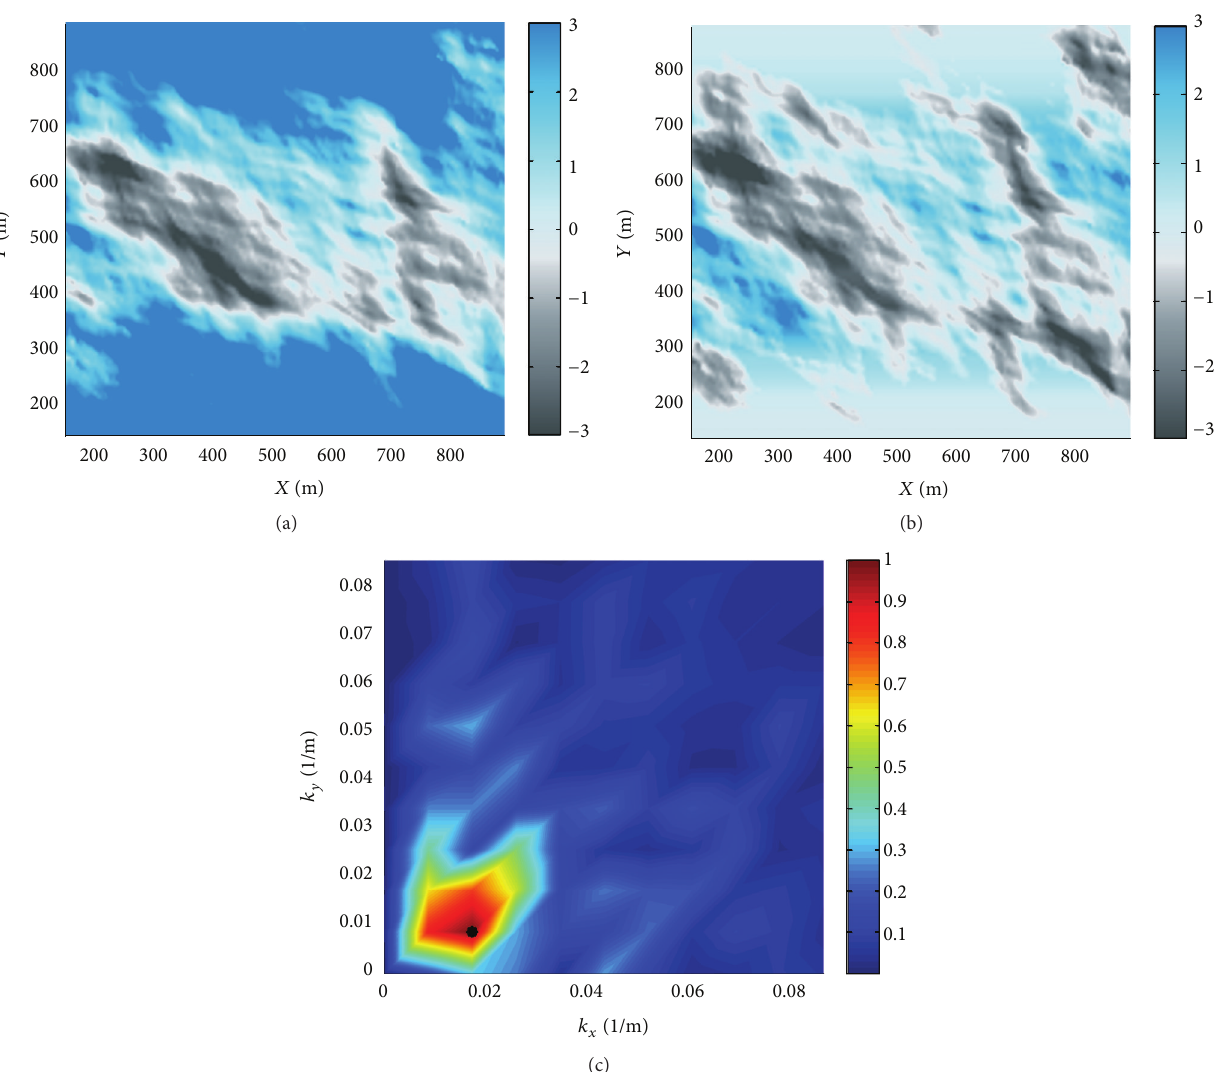
Figure 4: (a) Streamerwise imaged sea surface covering the same area as in Figure 3(a), (b) the same sea surface as in (a) but with the mean of each sea surface profile subtracted, and (c) the spectral plot of the imaged sea surface shown in (b). The indicated peak of the spectrum in (c) corresponds to 𝐾 𝑥 = 0.01704 and 𝐾 𝑦 = 0.00852 . The imaging technique was applied in 2D (i.e., streamerwise with each streamer taken in the inline